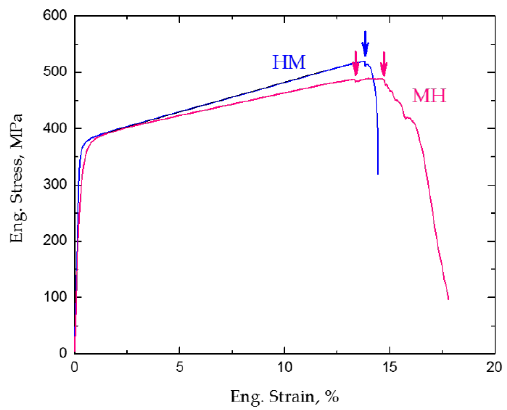
Figure 2. Engineering tensile stress–strain curves for the HM and MH specimens.